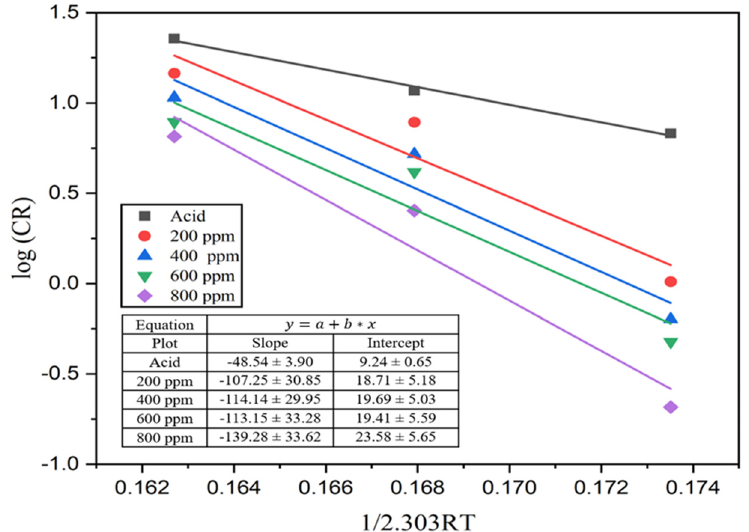
Figure 9. Arrhenius plot for the MS sample in 1M H 2 SO 4 and different concentrations of the inhibitor solutions.